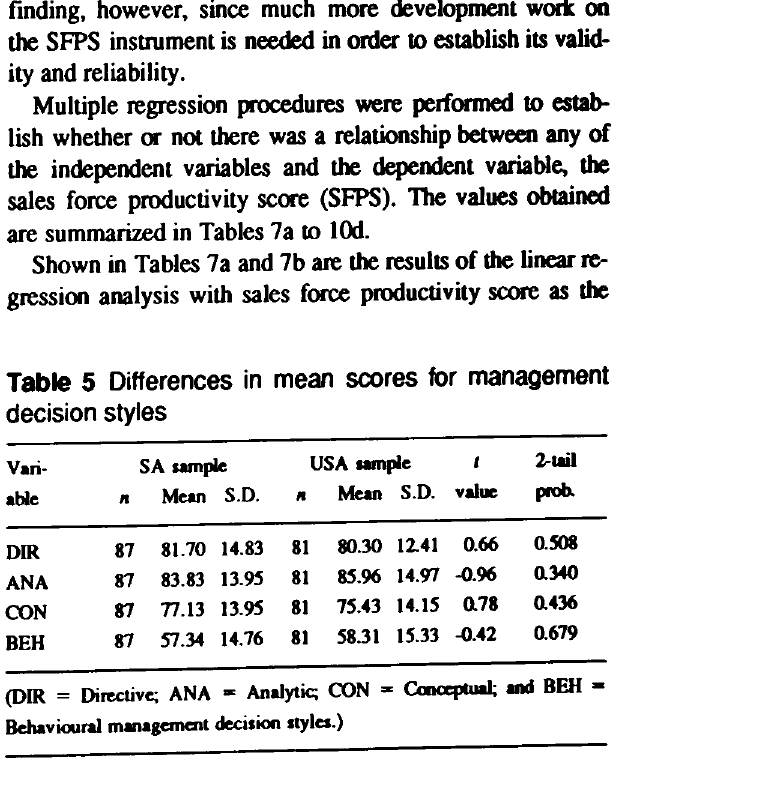
Table 3 Differences in mean scores for organizational commitment